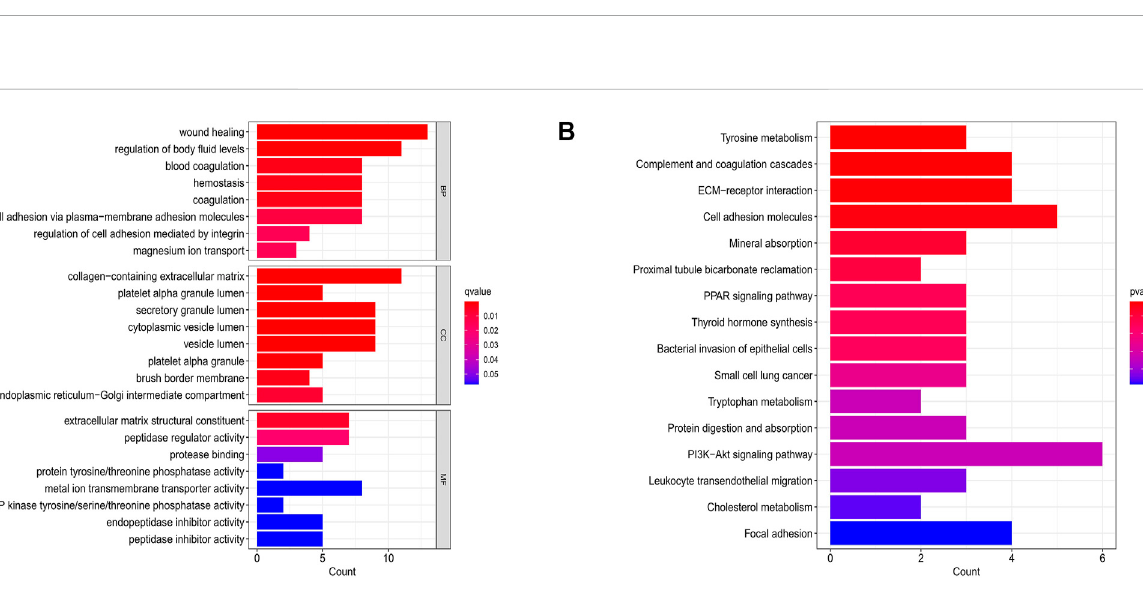
FIGURE 3 The results of GO and KEGG enrichment analysis. (A) The GO function enrichment analysis of DEGs. The X -axis stands for count of genes. The Y -axis represents BP, CC, and MF. (B) The KEGG pathways enrichment analysis of DEGs. The abscissa shows the count of genes, and the ordinate exhibits